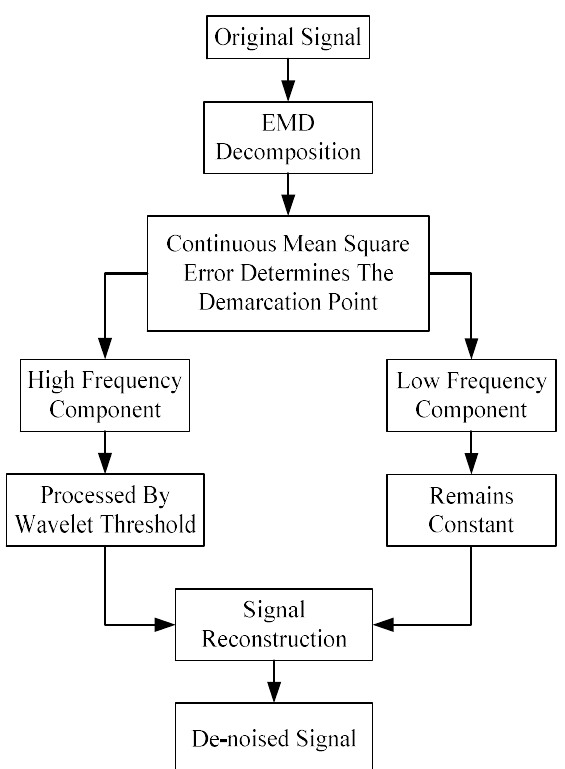
Figure 1. Block diagram based on empirical mode decomposition (EMD) wavelet threshold algorithm.